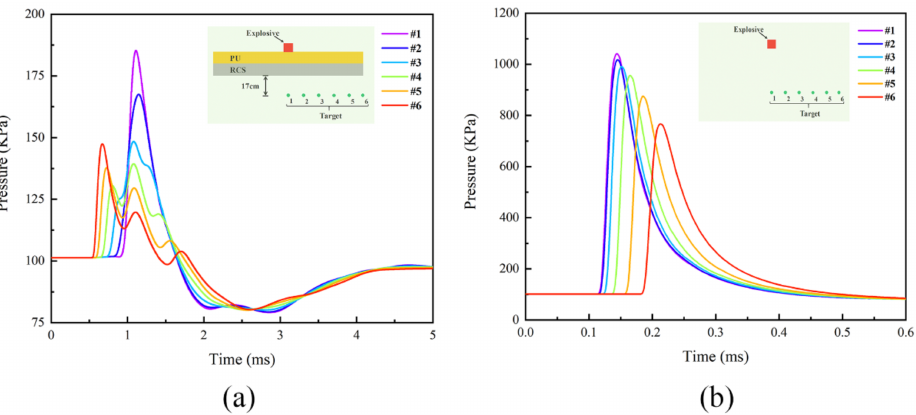
Figure 25. Pressure histories at targets from contact explosion and free field explosion in the CEL model: ( a ) contact explosion; ( b ) free field